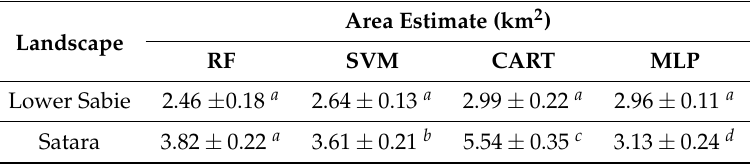
Table 7. Accuracy adjusted area estimates of grazing lawn cover in Lower Sabie and Satara landscapes. Area estimates with different letters differ significantly and vice versa in each landscape. RF = Random Forest, SVM = Support Vector Machines, CART = Classification and Regression Trees, MLP = Multilayer Perceptron.